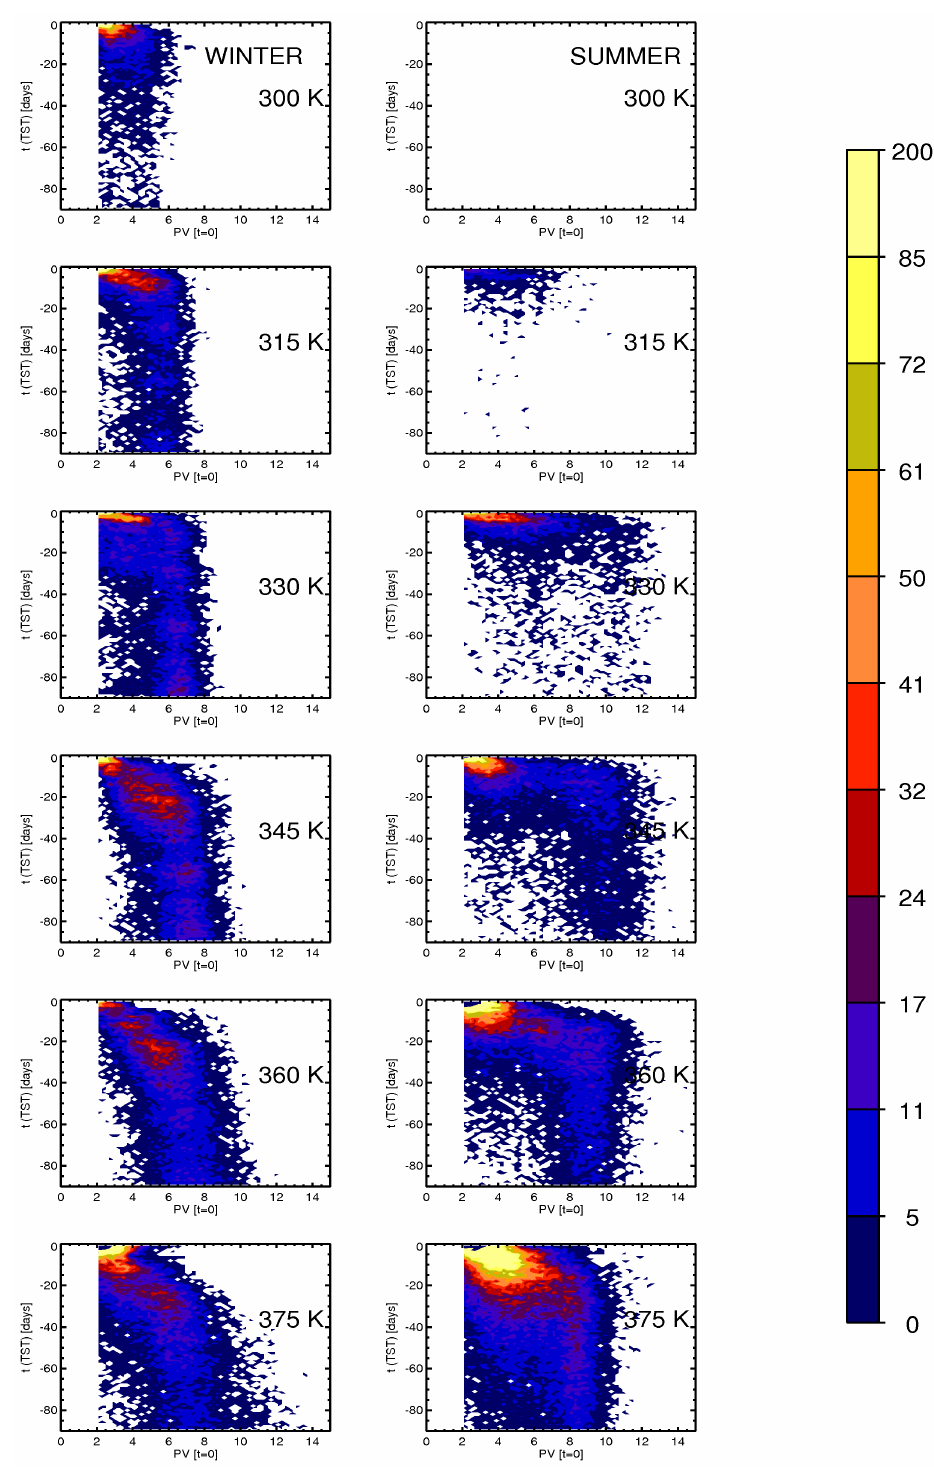
Fig. 4. Scatter plot of PV at time of trajectory initialization ( t =0) and time since last TST ( t TST ) on different isentropes from 2 =300–375K in steps of 15K for winter(left) and summer(right), respectively. The colours show the number of data points binned in steps of 0.2PVU and one day with higher number densities in yellow to red.